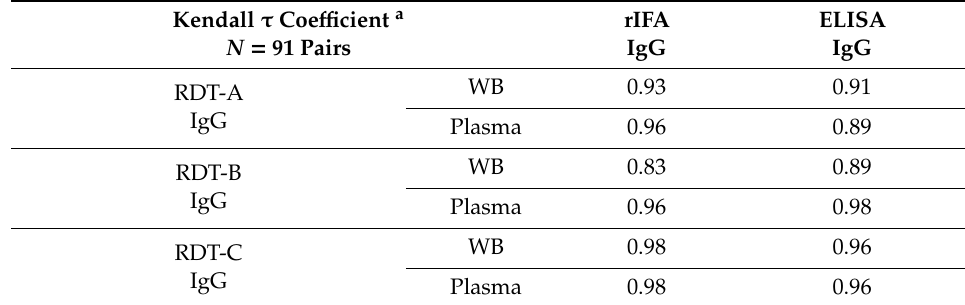
Table 2. Correlation between RDT versus rIFA and ELISA